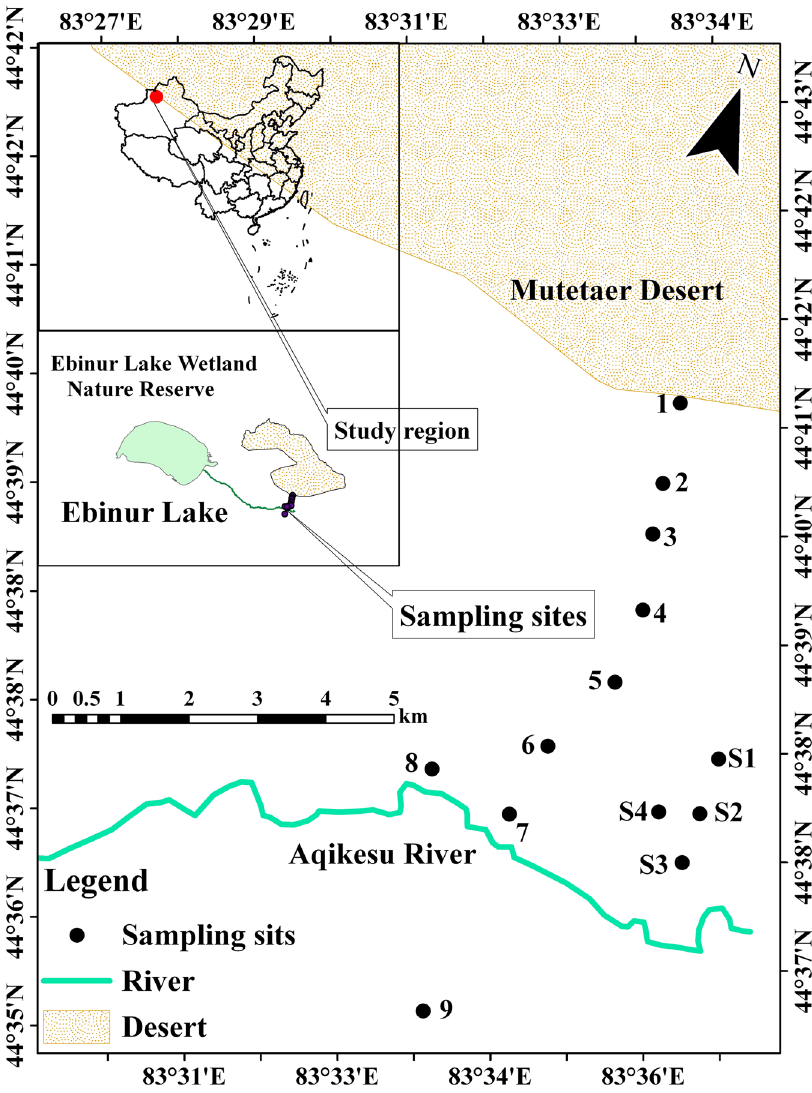
Figure 1. Sampling sites. An 8-km long transect was sampled in the Ebinur Lake Wetland Nature Reserve in Xinjiang Uygur Autonomous Region of China. A total of 13 sampling sites were selected along this gradient. Dry sampling sites were nos 1–3, humid-saline sites were nos 4–9, humid-non-saline sites were nos S1–S4. This figure was originally generated using the software ArcGIS 10.0 (http://www.esri.com/software/arcgis/